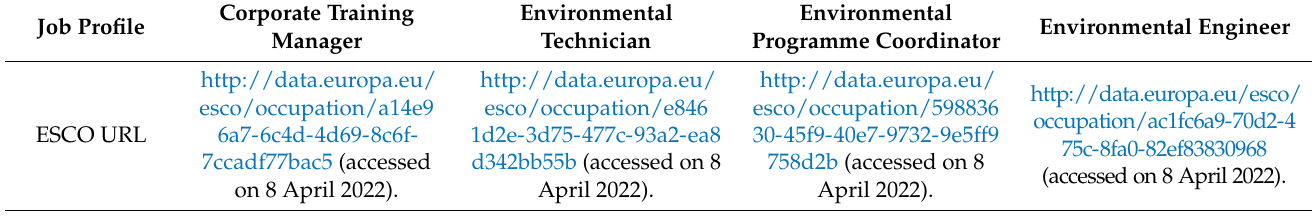
Table 3. An overview of the generated database: name of the job profile, weblink for ESCO, alternative labels for the profile, profile description and ISCO